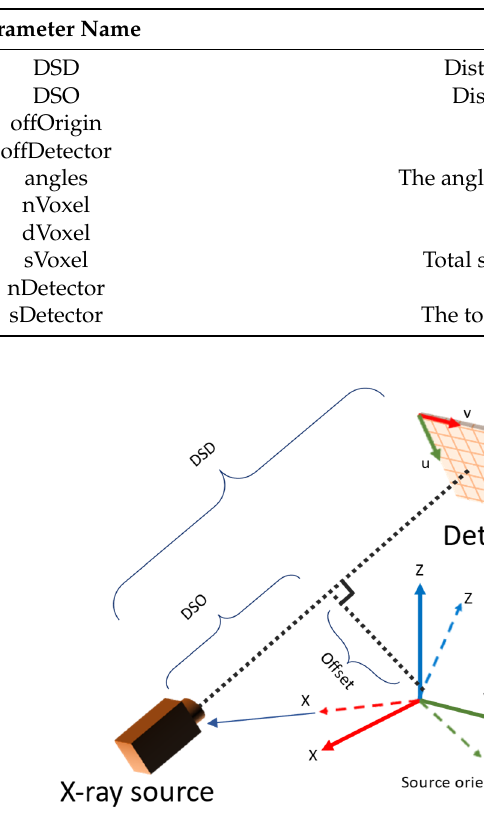
Table 1. List of parameter names used in TIGRE along with their descriptions.